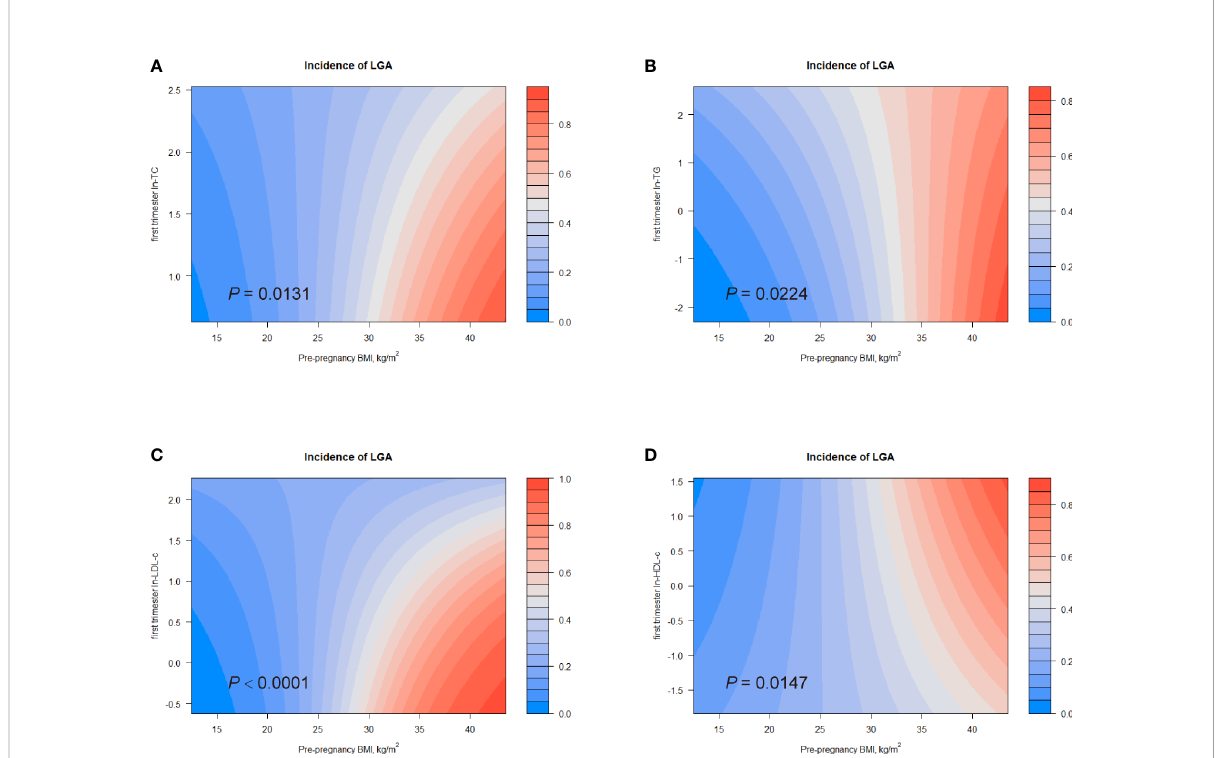
FIGURE 4 Combined effects of maternal pre-pregnancy BMI and lipid pro fi les in early pregnancy on incidence of LGA. Heat map for the correlation of incidence of LGA (red represents increased risks of LGA, blue represents decreased risks of LGA) according to the interaction of pre-pregnancy BMI and (A) ln-TC, (B) ln-TG, (C) ln-LDL-c, or (D) ln-HDL-c. Analyses were adjusted for maternal pre-pregnancy BMI, age, mode of conception, parity, education, consumption of cigarettes, infant sex, gestational diabetes and gestational hypertension